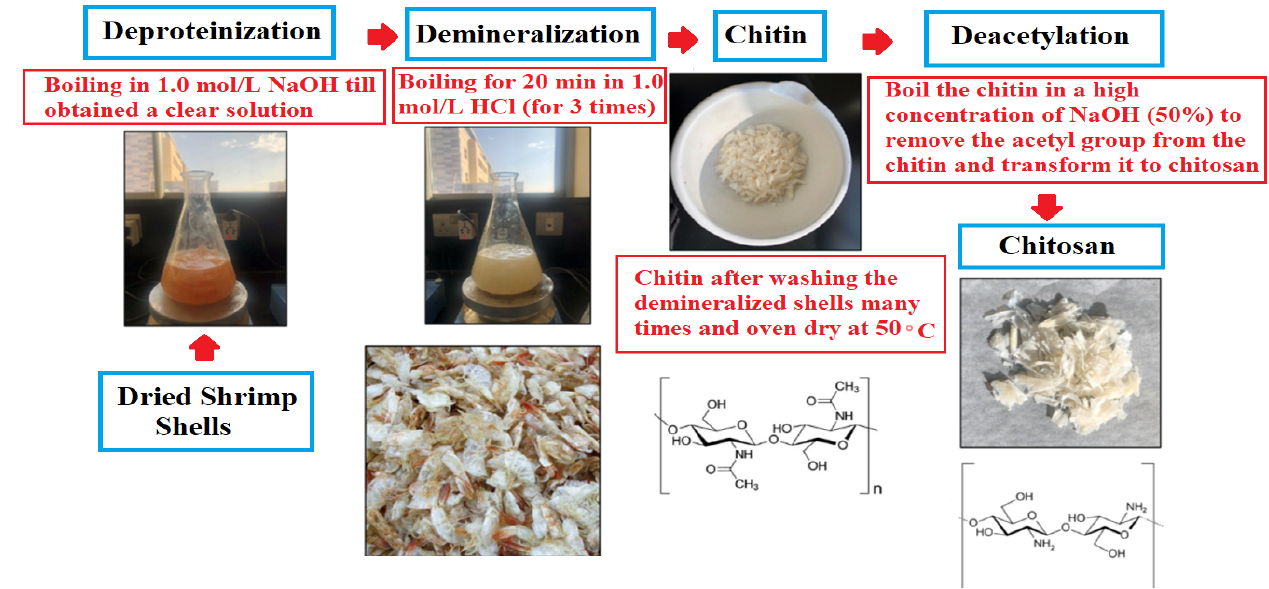
Scheme 1. Schematic illustration described the isolation steps of chitin from white shrimp shells and the production of chitosan by deacetylation of the isolated